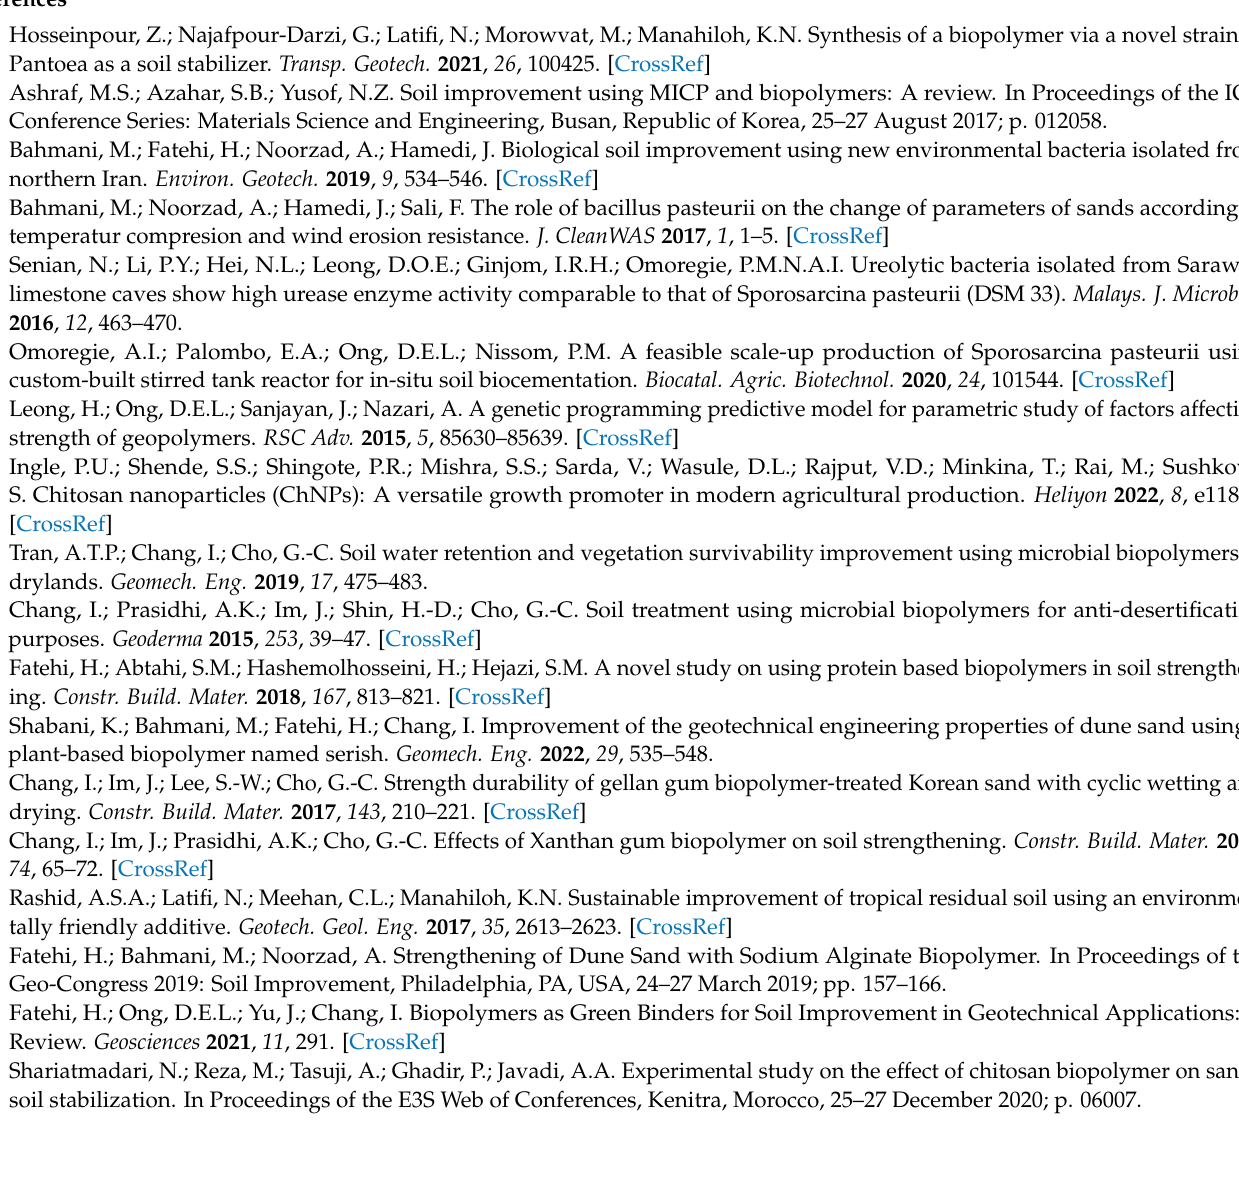
Figure A2. ( a ) UCS mold, ( b ) We tt ing phase of wet–dry cycle.